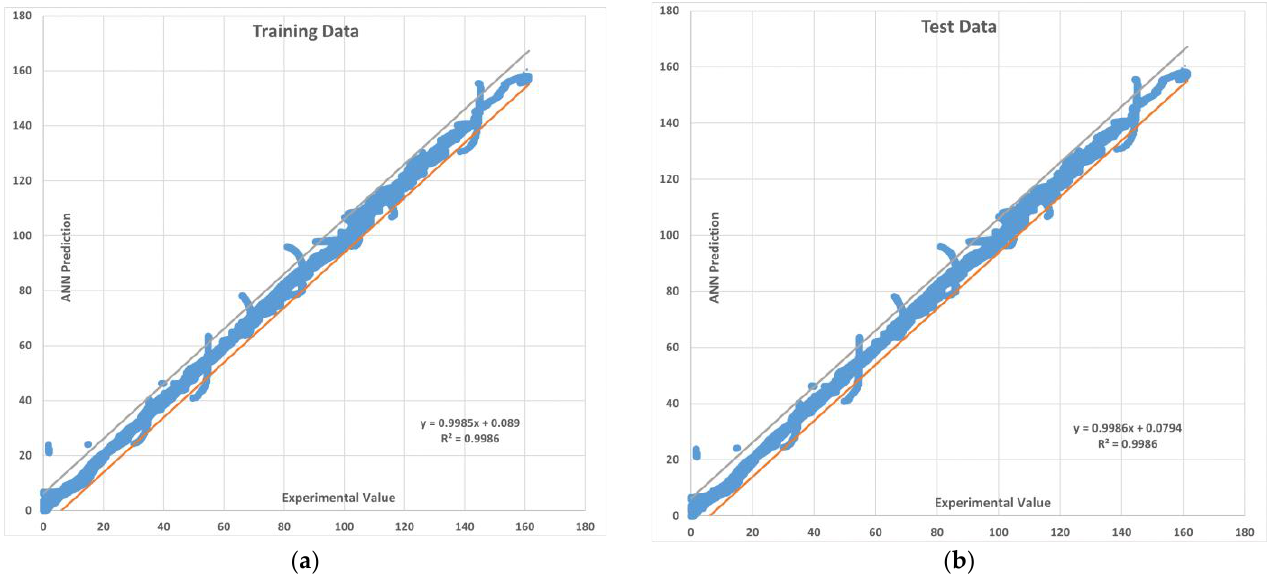
Figure 9. The 99% prediction interval with upper and lower limits for the MLA with two hidden layers. ( a ) Training data ( b ) Testing data.